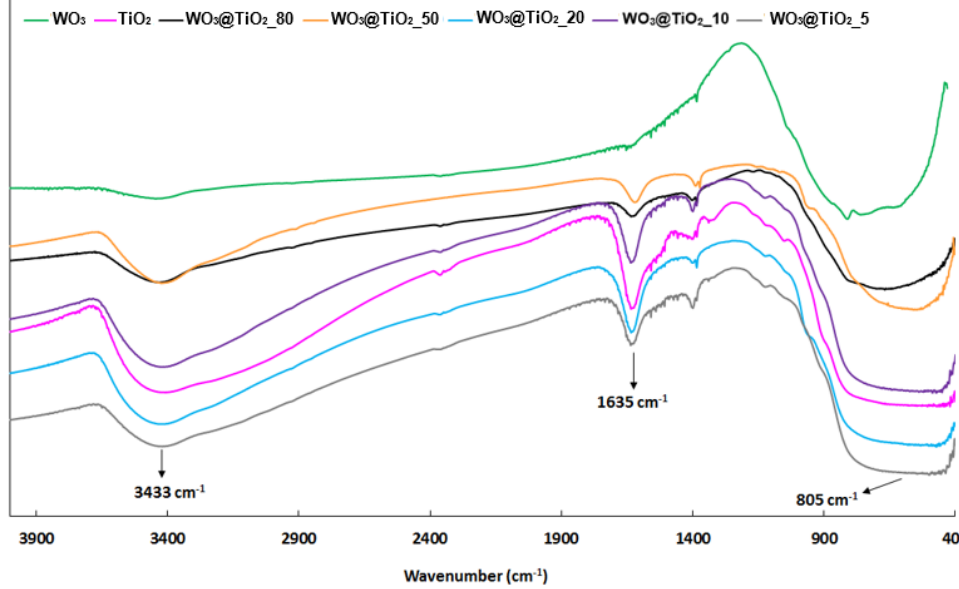
Figure 3. FT − IR spectra of the samples calcined at 400 °C.